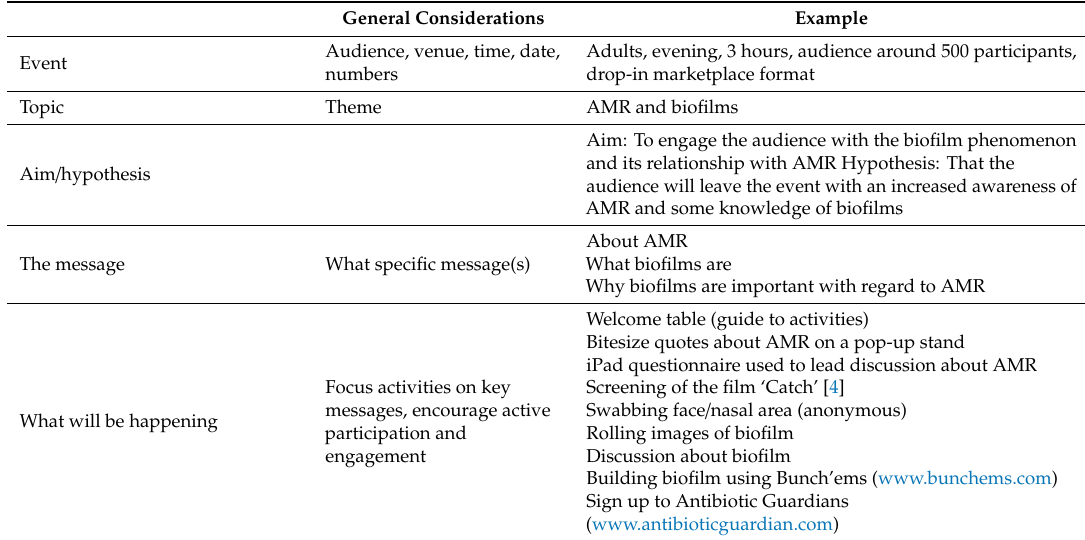
Table 1. Checklist for public engagement events, with accompanying information detailing planning for a proposed event focusing on antimicrobial resistance (AMR) and